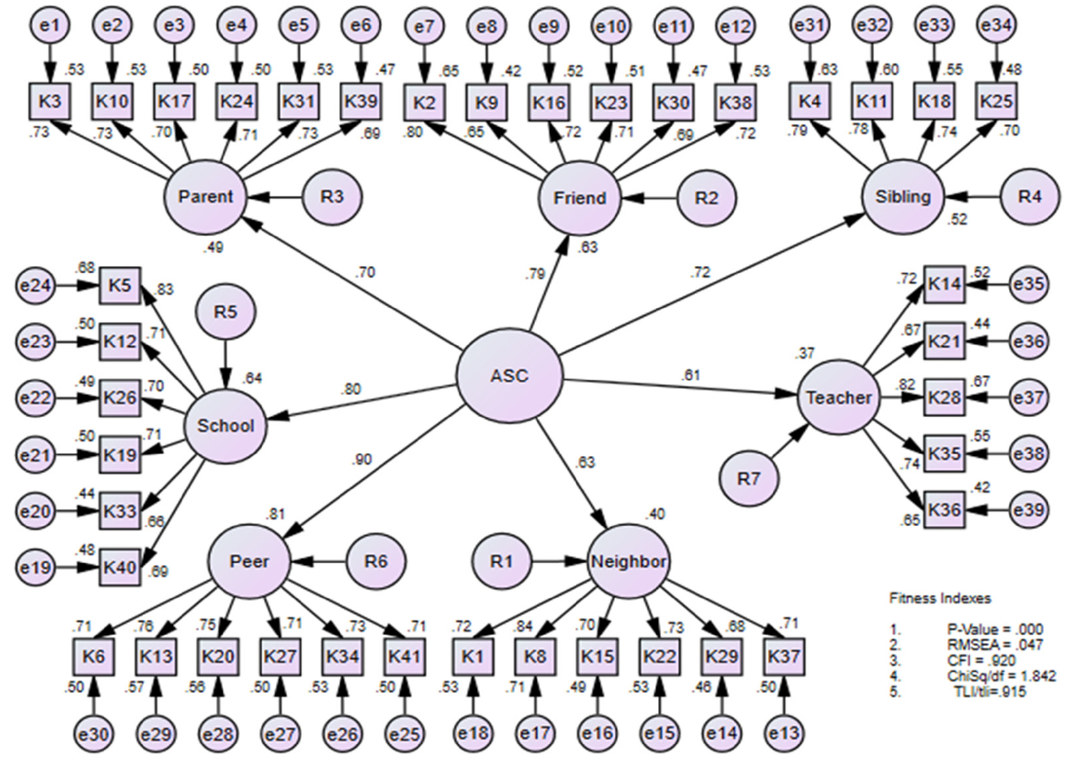
Figure 1. Second-order 7-factor confirmatory factor analysis model (n = 377). Note. RMSEA: Root Mean Square Error of Approximation; CFI: Comparative Fit Index; TLI: Tucker–Lewis Index. ASC = adolescent social connectedness; parent = parent connectedness; school = school connectedness; Peer = peer connectedness; Neighbor = neighborhood connectedness; Teacher = teacher connectedness; Sibling = sibling connectedness.